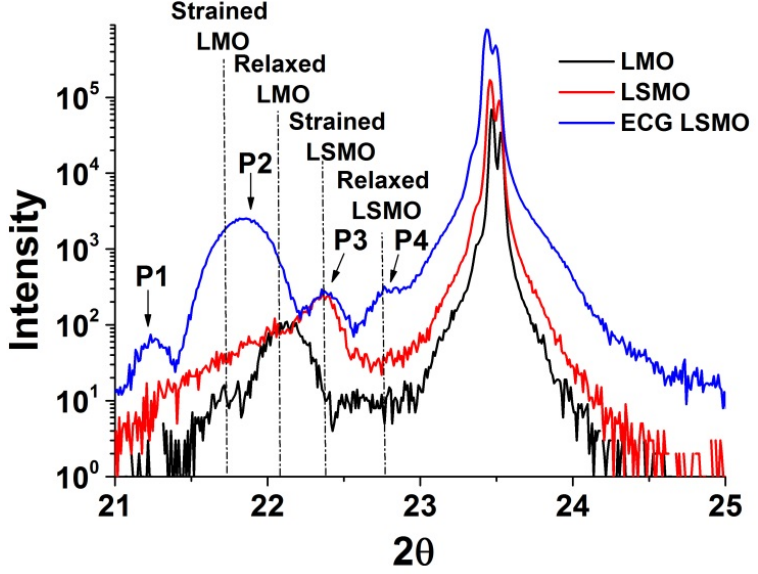
Figure 2. θ –2 θ symmetric diffraction patterns of pure LMO, pure LSMO and ECG LSMO films grown on LAO substrate; Arrows indicate the positions of the peaks assigned to the (001) reflection of graded LSMO film. The four dotted lines correspond to the value of out-of-plane lattice parameters of strained LMO, relaxed LMO, strained LSMO and relaxed